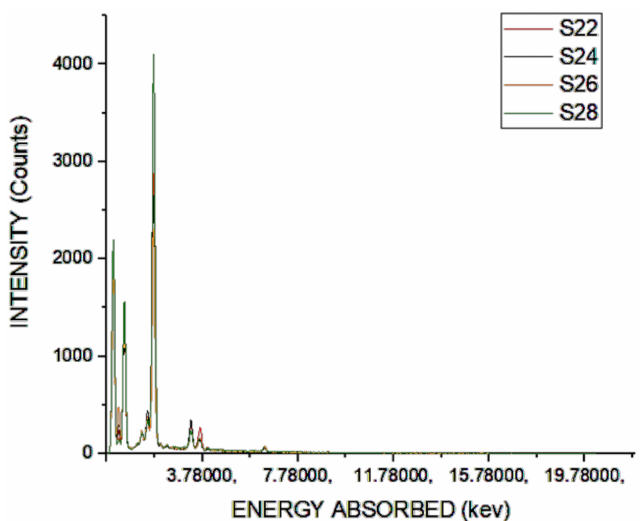
Figure 3. Chemical analysis of S22 to S28.